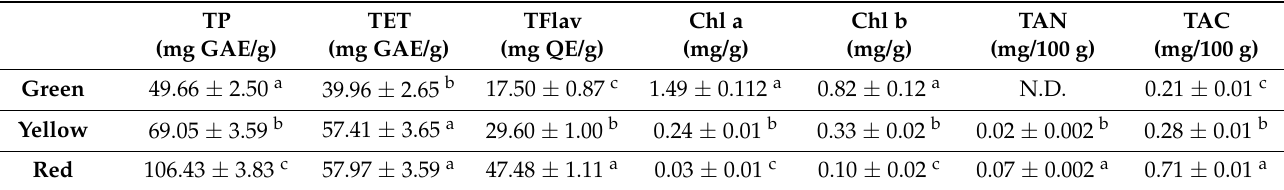
Table 1. Total content of different